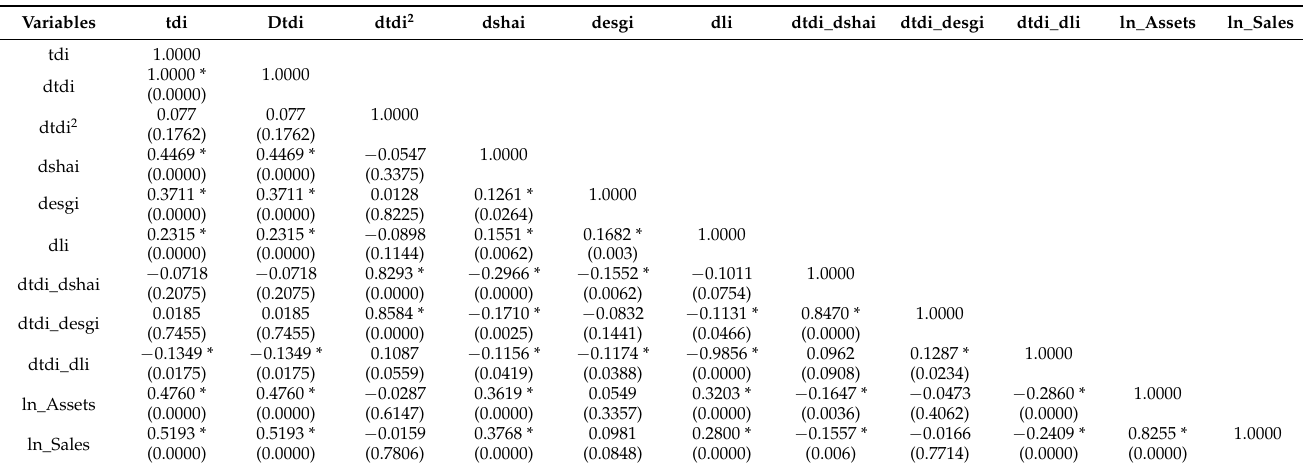
Table 3. Correlation Matrix.